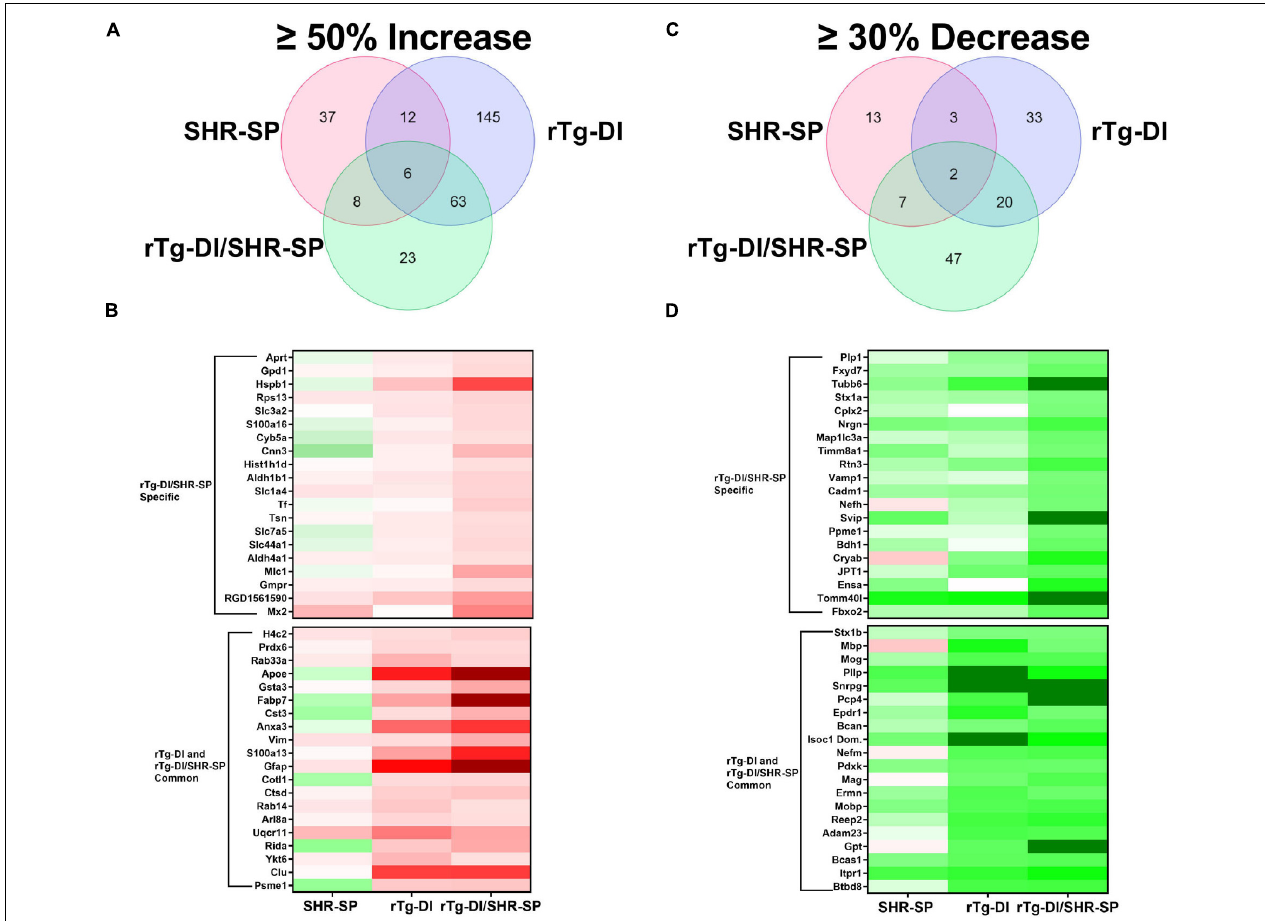
FIGURE 11 | Comparison of significantly enhanced and reduced proteins in the 10 M SHR-SP, rTg-DI and bigenic rTg-DI/SHR-SP cortex. (A) Venn diagram comparing significantly ( P < 0.05) enhanced proteins by ≥ 50% of the WT concentration in the cortex of 10 M SHR-SP, rTg-DI and bigenic rTg-DI/SHR-SP rats ( n = 5, 6). (B) Heat map depicting relative expression of most abundantly enhanced cortical proteins in the bigenic rTg-DI/SHR-SP only (top) or common to both rTg-DI and bigenic rTg-DI/SHR-SP, along with the corresponding expression in the SHR-SP cortex, with red indicating enhanced expression, green representing reduced expression, and color intensity representing the degree of expression change. (C) Venn diagram comparing significantly ( P < 0.05) reduced proteins by ≥ 30% of the WT concentration in the cortex of 10 M SHR-SP, rTg-DI and bigenic rTg-DI/SHR-SP rats ( n = 5, 6). (D) Heat map depicting relative expression of most reduced proteins arranged as in (B) with color shading as in (B)